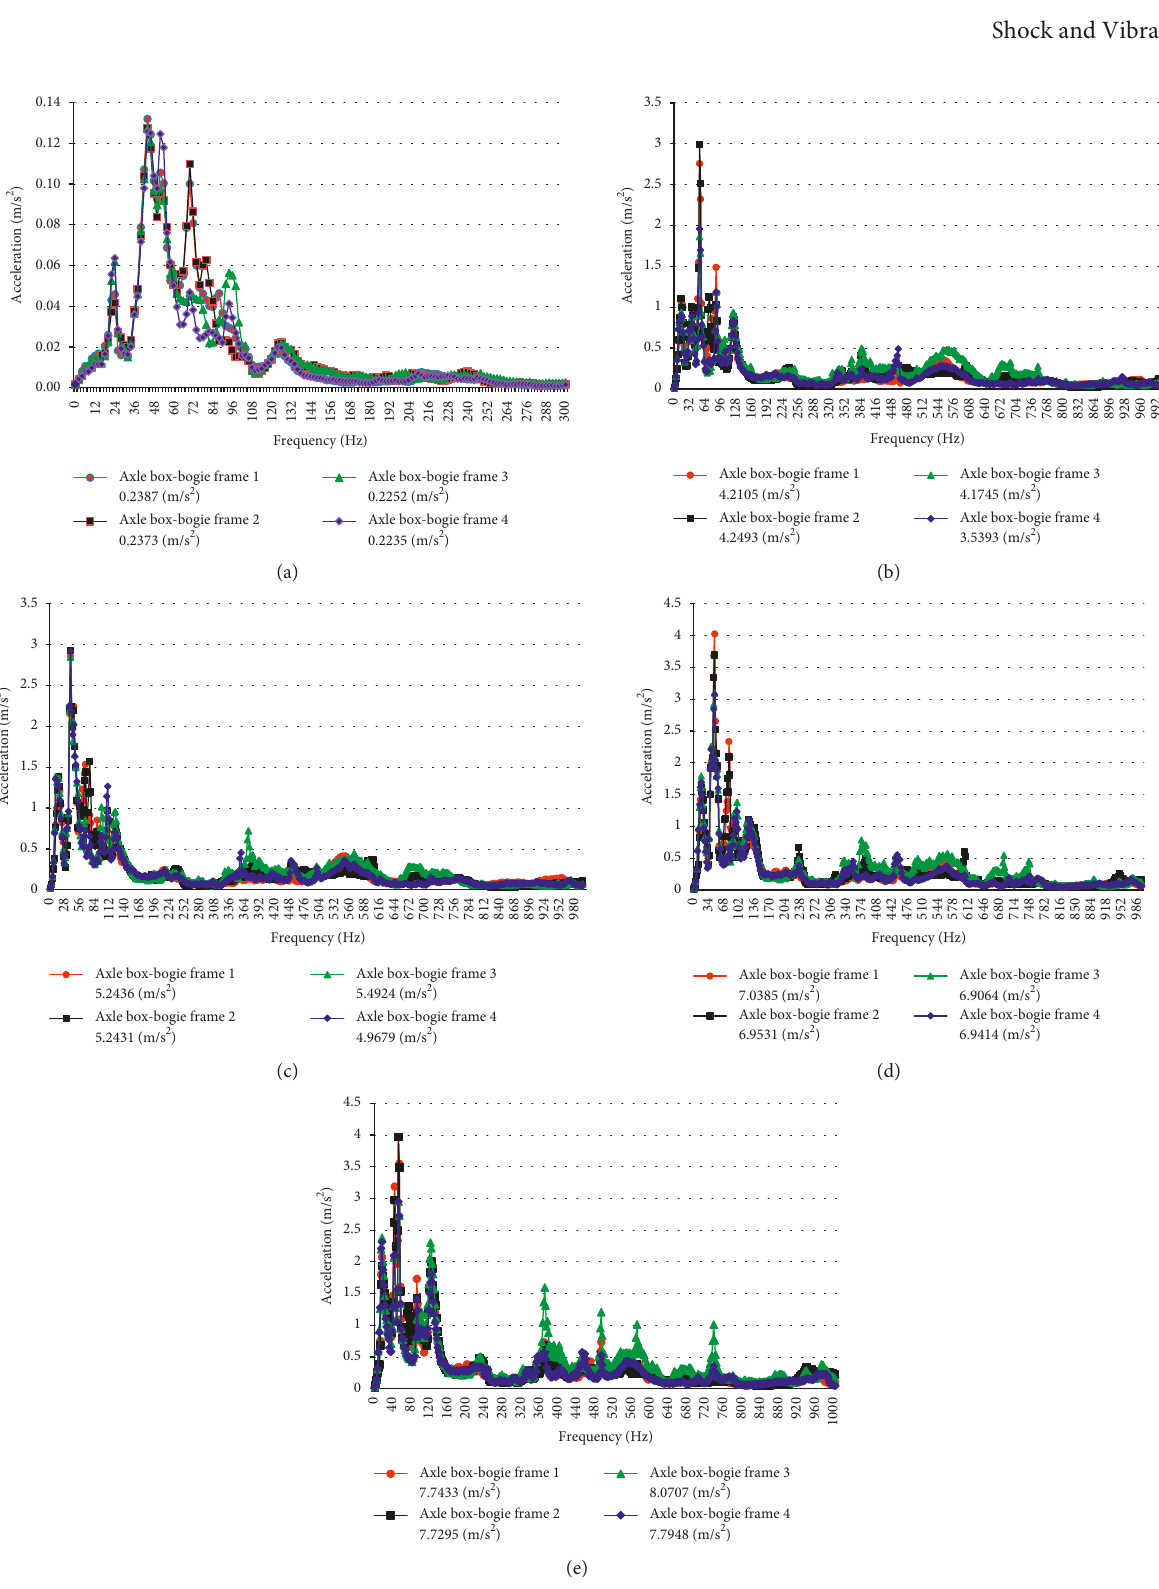
Figure 8: FFTspectrum of the Z -axis of the axle box-bogie frame at each speed. (a) 5km/h. (b) 200km/h. (c) 250km/h. (d) 300km/h. (e)